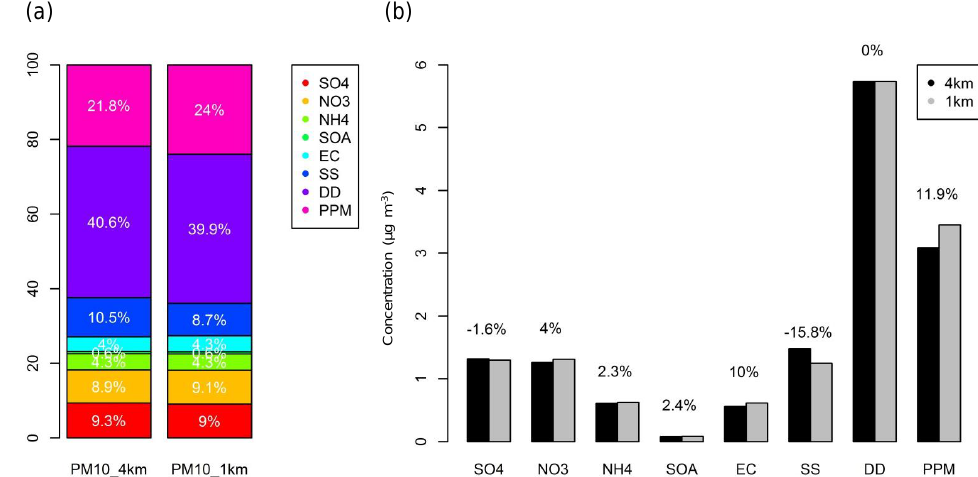
Figure 8. Resolution effect on PM 10 components in April 2013. (a) Percentage of PM 10 components: sulfate (SO 4 ), nitrate (NO 3 ), am- monium (NH 4 ), secondary organic aerosol (SOA), elemental carbon (EC), sea salt (SS), desert dust (DD), and primary particulate matter (PPM). (b) PM 10 component concentrations in the 1km simulation (black) and 4km simulation (grey). Numbers over bars indicate the % increase when increasing the